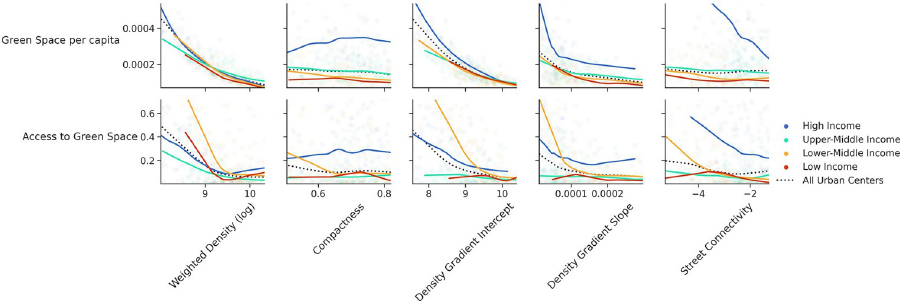
Fig 7. Correlation of urban form metrics with green space measures across income